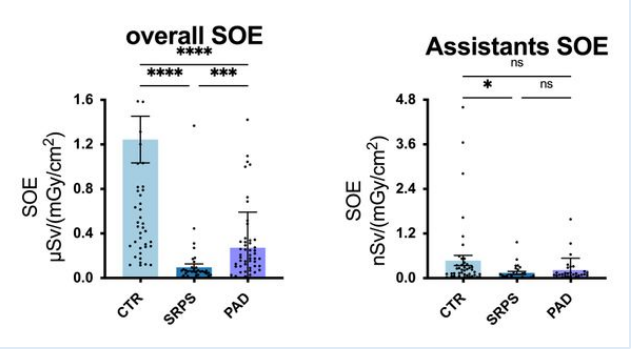
Figure 1. The overall SOE of the primary operator and the